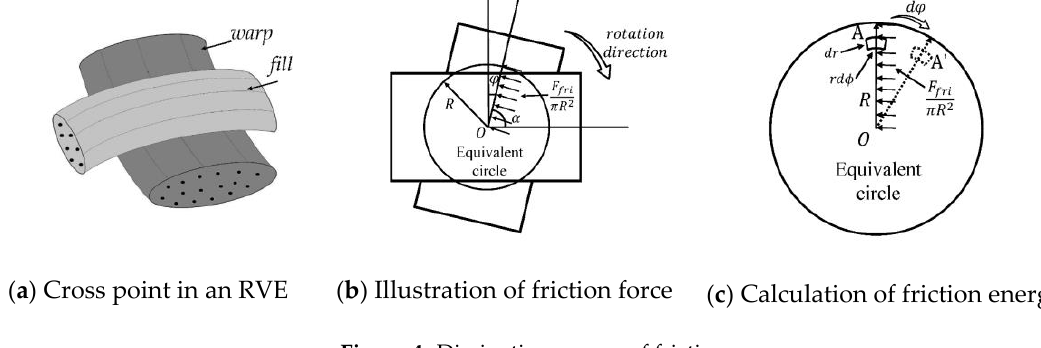
Figure 4. Dissipation energy of friction.